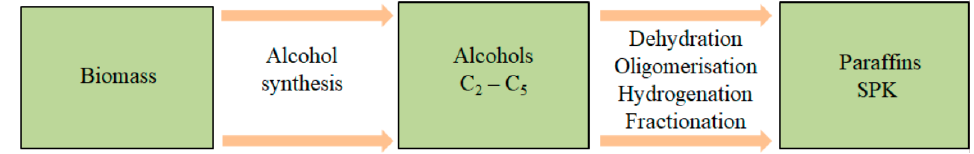
Figure 2. Simplified diagram of the ATJ-SPK process